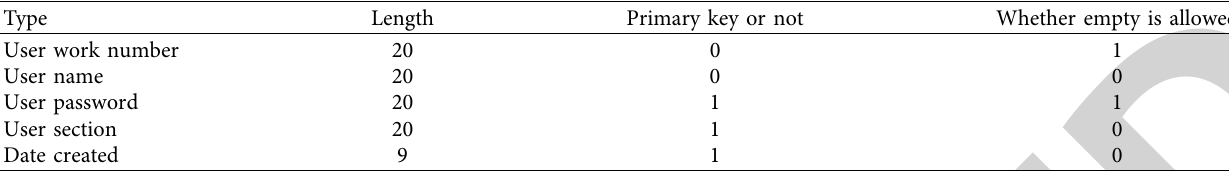
Table 3: User information specific situation table.